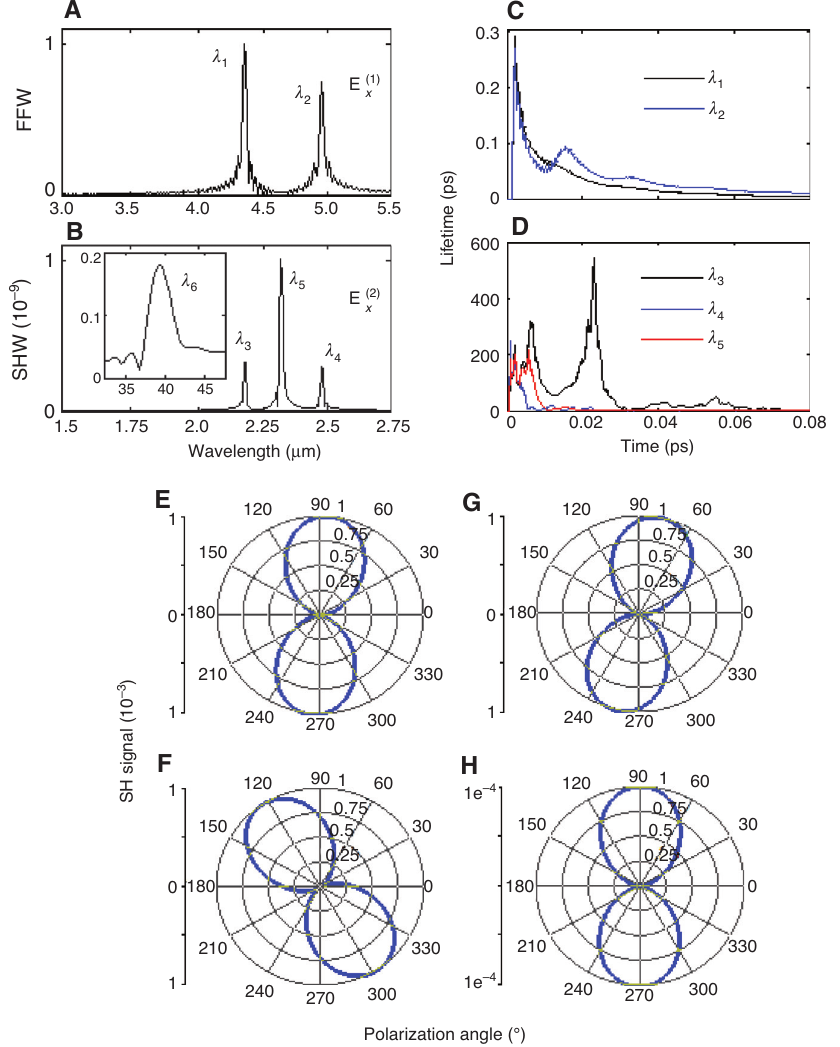
Figure 2: Wavelength and polarization dependent SHG of nanostructured DGN. (A) The amplitude of Fourier spectrum for FFW E (2) with the four wavelengths λ spectrum for SHW E x λ , λ , and λ changing with time. The polarization state of total electric field energy (|E| 2 ) for second harmonic emission at (E) λ 3 4 5 and (H) λ from an array of DGN illuminated with an x -polarized plane wave at the fundamental frequency λ 6